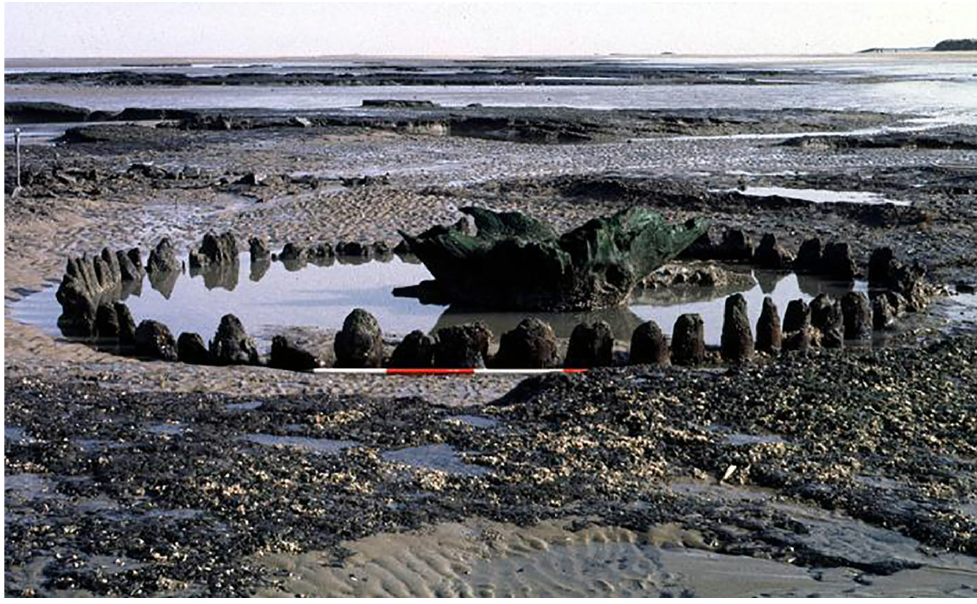
Figure 2. Seahenge at Holme-next-the-Sea, Norfolk, England. Photo: Mark Brennand, Norfolk Archaeological Unit/English Heritage, used with